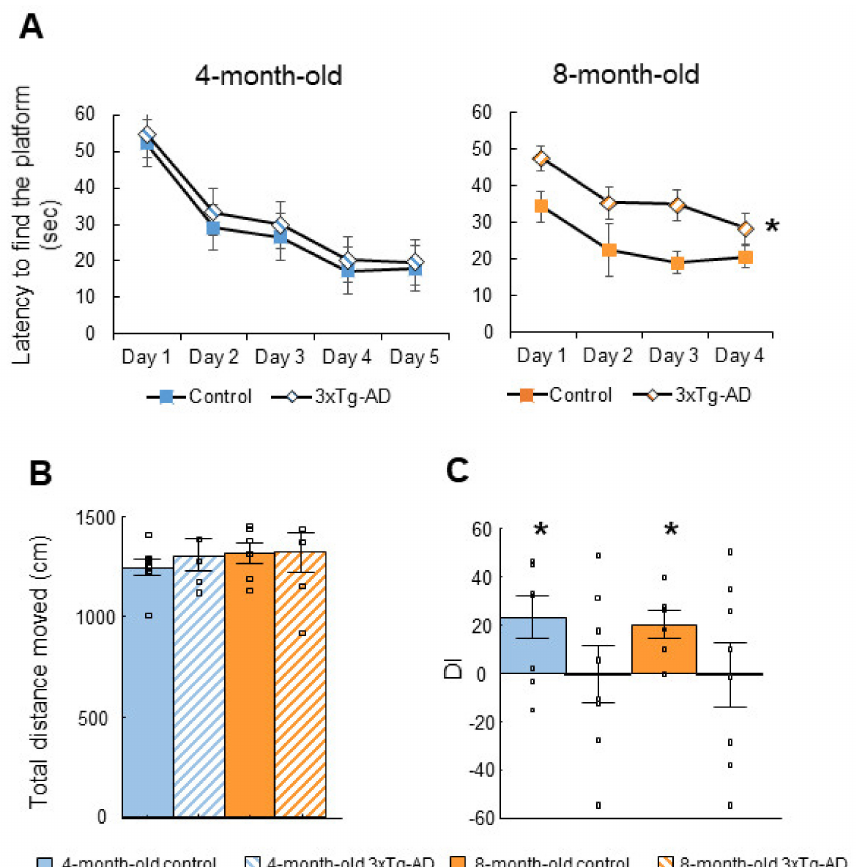
Figure 1. Cognitive behavior. A-B: The Morris Water Maze (MWM) test. ( A ): 3xTg-AD mice found the platform slower at four months of age than their age-matched control counterparts with a genotype difference tendency only at day 5 ( p = 0.06). The genotypic difference increased further at 8 months of age (* p = 0.00). ( B ): Results of the MWM probe test. There was no significant difference in the total distance moved ( p < 0.05). ( C ): The social discrimination (SD) test. The discrimination index (DI) of the 3xTg-AD mice was not significantly different from zero (4-month-old: p = 0.99; 8-month-old: p = 0.98). In contrast, control group had intact social memory throughout (4-month-old: * p = 0.03; 8-month-old: * p =